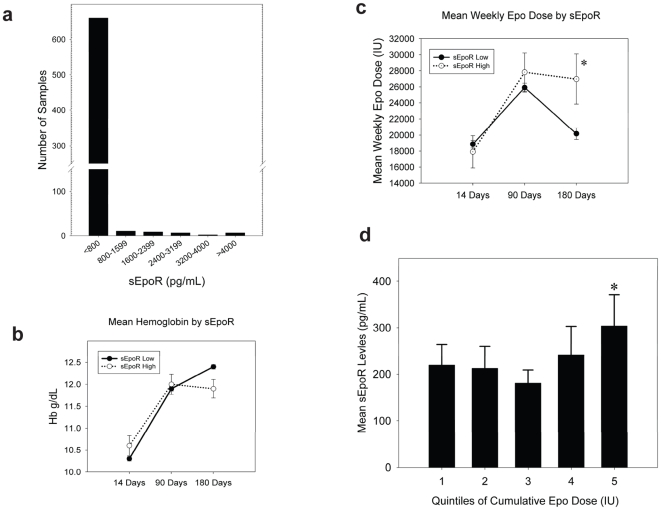
Relationship of sEpoR and erythropoietin dosage in human ESRD subjects.
2a. This figure shows the distribution of sEpoR levels as measured by ELISA in our sample of 697 dialysis patients. 2b. Erythropoietin dose over time for the Low and High sEpoR groups. Erythropoietin dose at the start of dialysis (Days 0 to14) was the same in both groups, 17,908 IU/week in the High sEpoR group vs. 18,851 IU/week in the Low sEpoR group. Between days 14 and 90 the High group received 27,819 IU/week vs. 25,906 IU/week in the Low group. By days 90 and 180 the High sEpoR group required a significantly greater dose of erythropoietin then the Low sEpoR group (26,977 IU/week vs. 20,173 IU/week, p = 0.038). It is notable that the average dose rose in both groups over the period 14 to 90 days but then fell again over the 90 to 180 day period as might be expected in patients starting erythropoietin therapy. 2c. Mean hemoglobin was compared for the Low and High sEpoR groups at three time points (Days 0 to14, 14 to 90 and 90 to 180). Hemoglobin at the start of dialysis (Days 0-14) was not statistically different between the High and Low sEpoR groups (10.5 vs. 10.3 mg %). Between 90 and 180 day there was a trend toward lower hemoglobin in the High sEpoR group 12.4 vs. 11.9 that approached statistical significance (p = 0.054). This suggests that even though both groups likely had identical hemoglobin targets, the high sEpoR group may have impaired erythropoietin response even with significantly higher erythropoietin dose. 2d. The cohort was divided according to quintiles of cumulative EPO dose during the study period, and within each quintile examined the mean sEpoR level. The mean sEpoR values according to quintile were: Quintile 1: 220±44 pg/ml; Quintile 2: 213±47 pg/ml; Quintile 3: 181±28 pg/ml; Quintile 4: 242±61 pg/ml; Quintile 5: 304±67 pg/ml, p value for trend  = 0.038. The mean cumulative Epo doses in units according to quintile were: Quintile 1: 209,004±4863, Quintile 2: 347,019±2655, Quintile 3: 459,719±3362, Quintile 4: 622,460±5334, Quintile 5: 1,077,666±25,576.